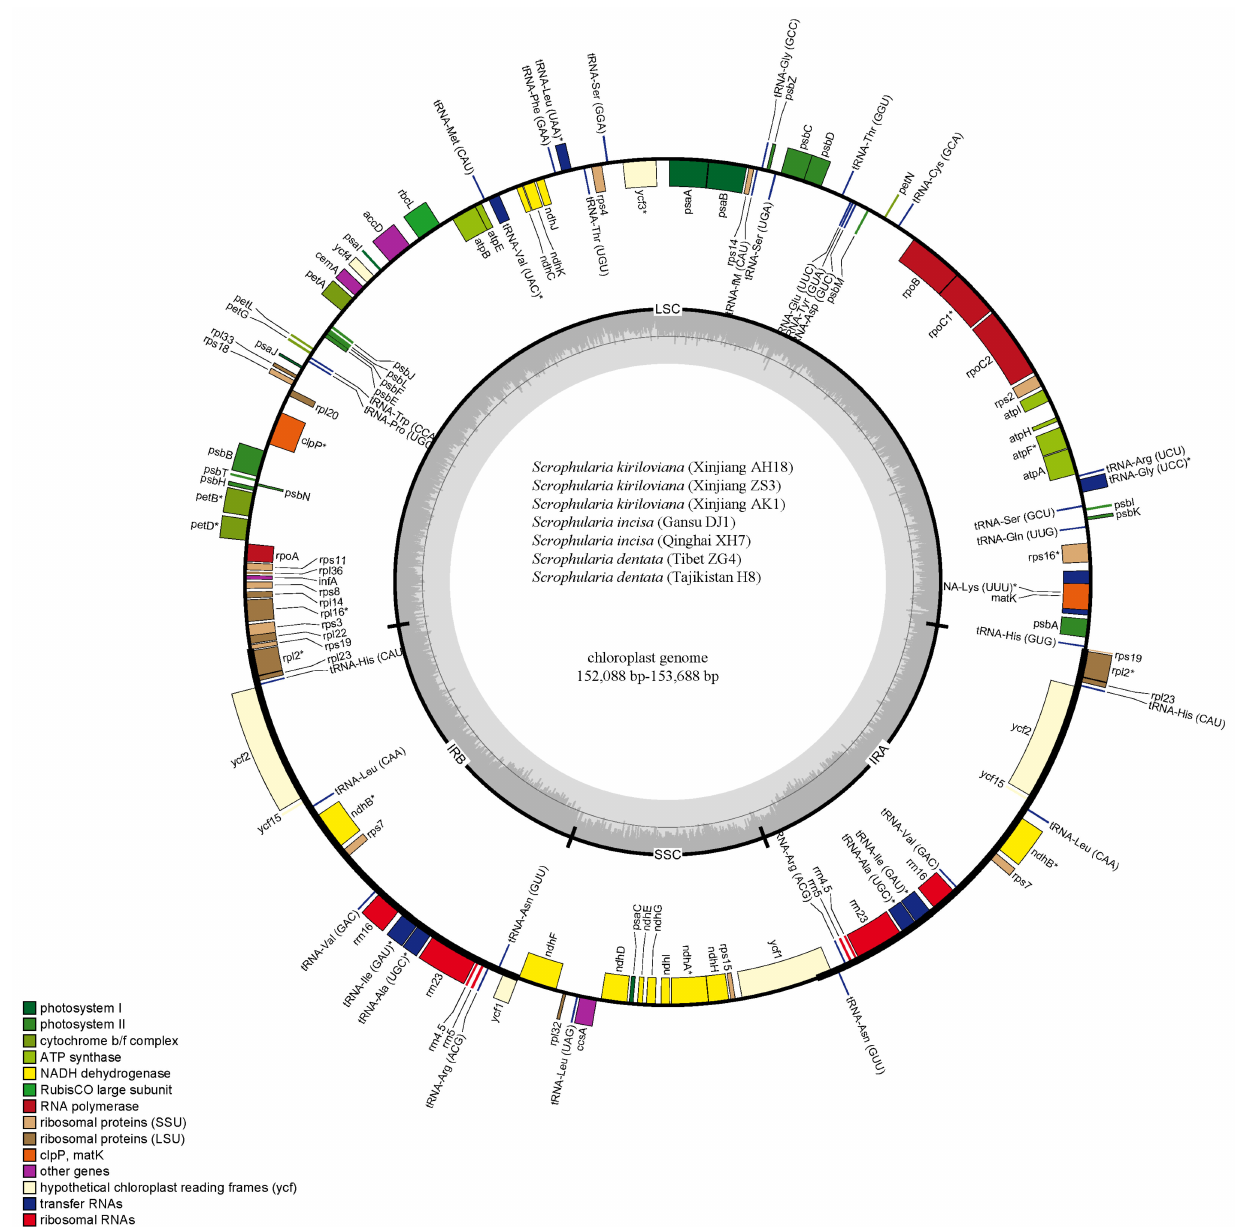
Figure 2. Gene maps of the seven S. sect. Caninae individuals including three S. kiriloviana , two S. dentata , two S. incisa and one S. integrifolia . Genes shown on the outside of the circle are transcribed clockwise, and genes inside are transcribed counterclockwise. Genes belonging to different functional groups are color-coded. The darker gray in the inner corresponds to GC content, and the lighter gray corresponds to AT